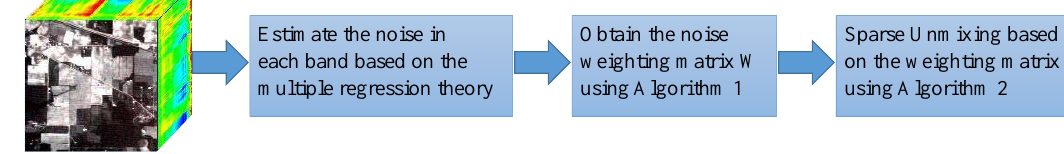
Figure 2. Algorithm flow of the proposed